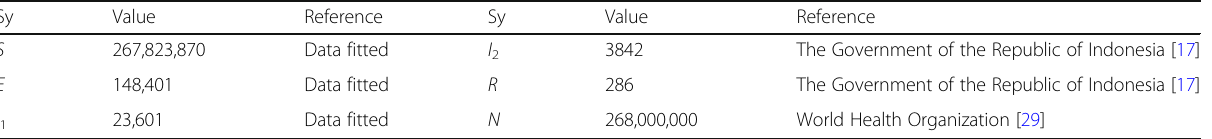
Table 1 Initial value of state variable for COVID-19 transmission in Indonesia Sy